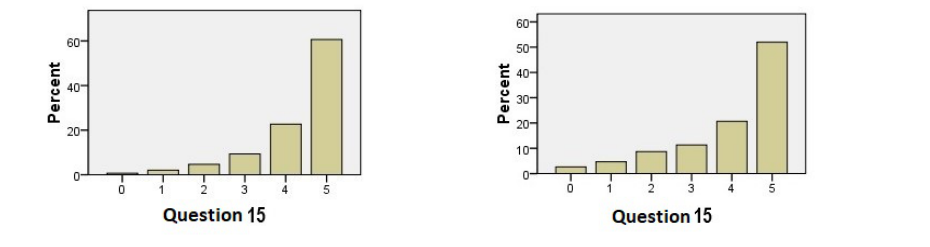
Figure 8: Equal segments Figure 9: Equal-area